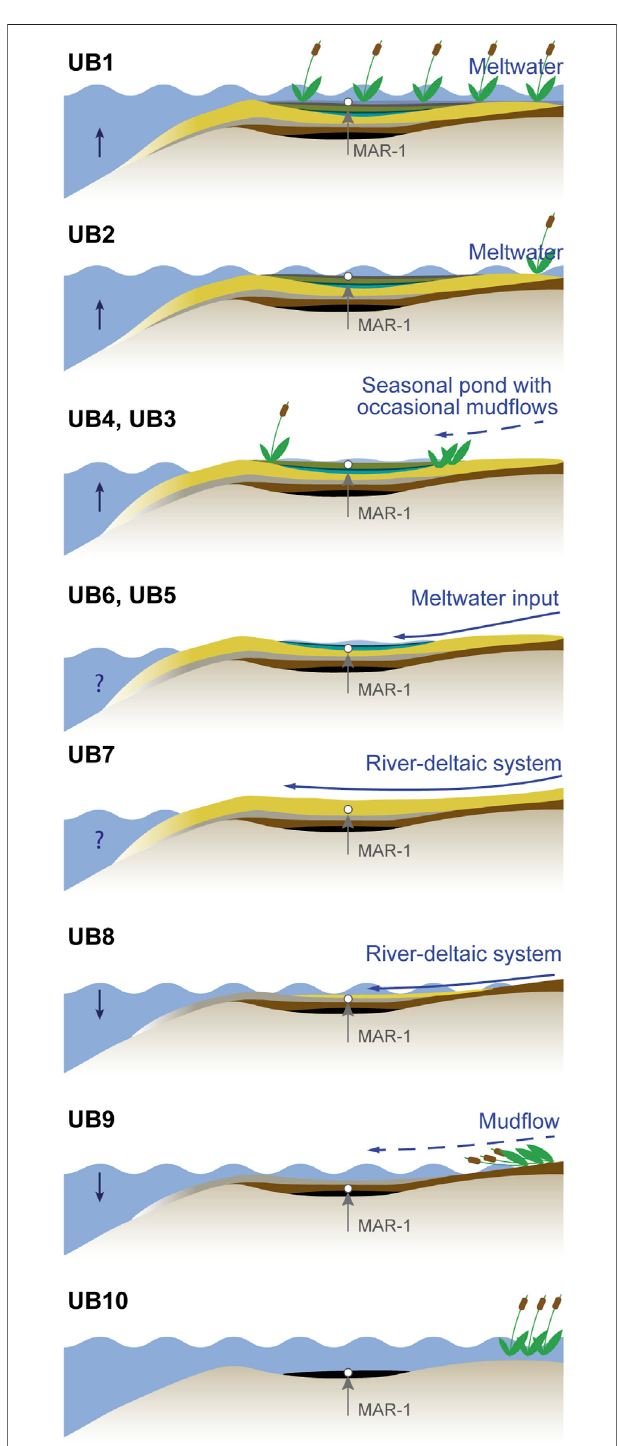
FIGURE 7 | Schematic overview of the sedimentation history of MAR-1 (not to scale).